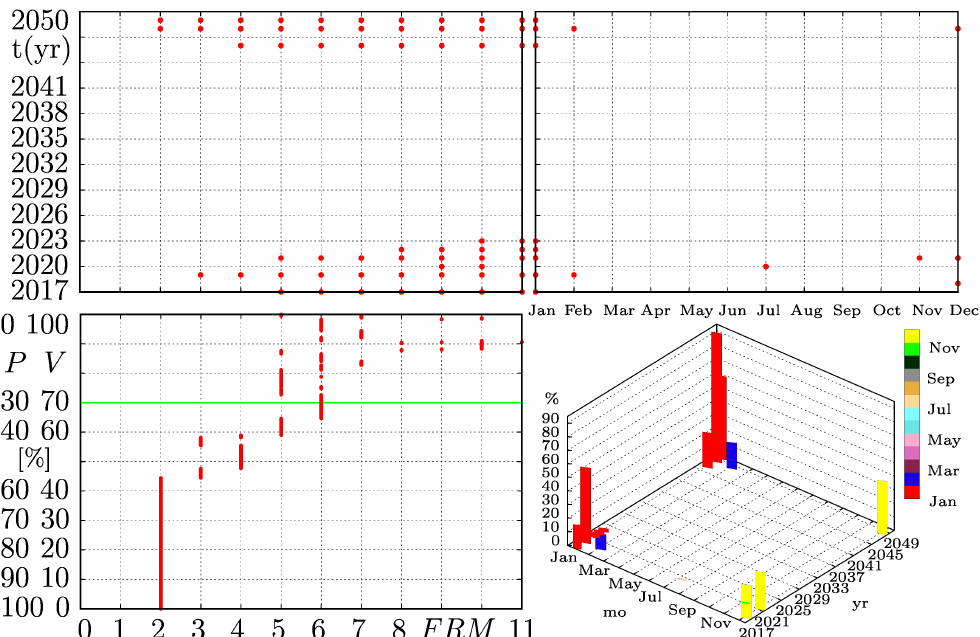
Figure 14. Input–output relationship diagram of the V / P scenarios once the ENSO phenomenon was incorporated in the model. FRM stands for frequency of rationing months. The Colombian case is marked by the green horizontal